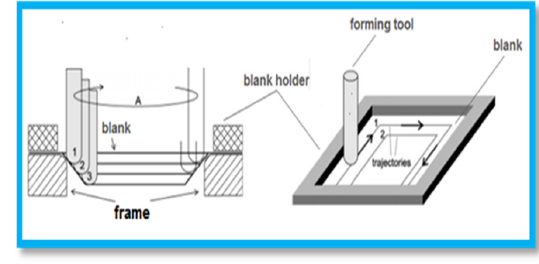
Fig. 1. Representation of SPIF process